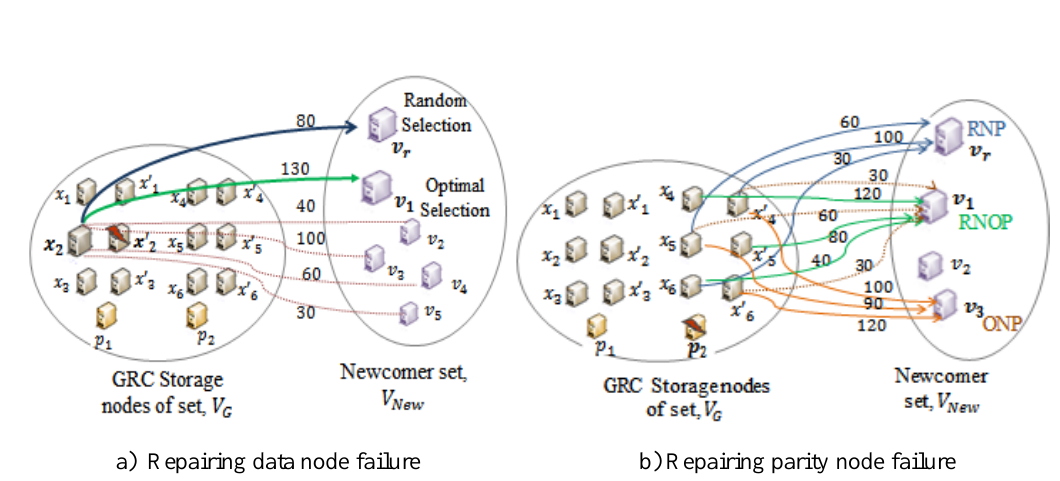
Figure 2. Data regeneration for data node and parity node failure in Group Repair Codes.